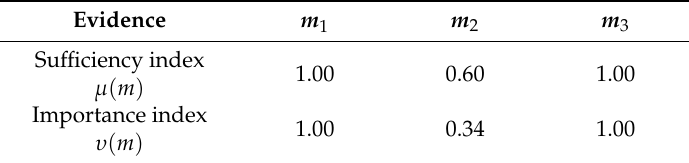
Table 8. Parameters in the fault diagnosis